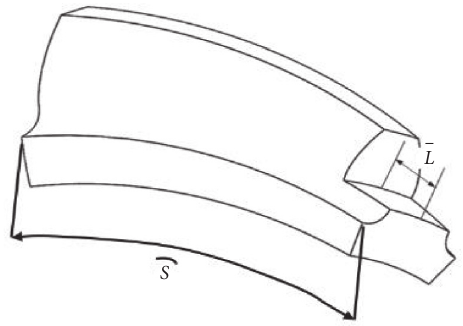
Figure 5: Geometric model of broken